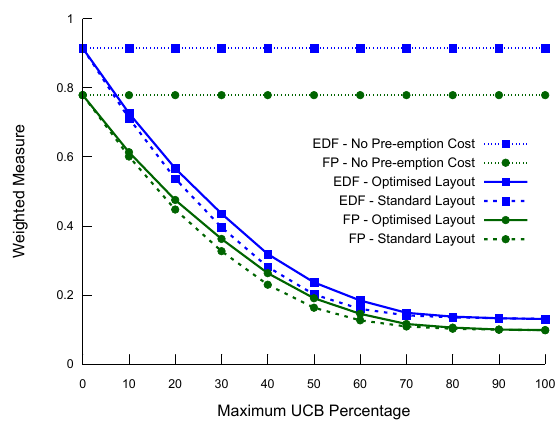
Figure 11 Weighted measure for varying the maximum UCB percentage from 0 to 100 in steps of